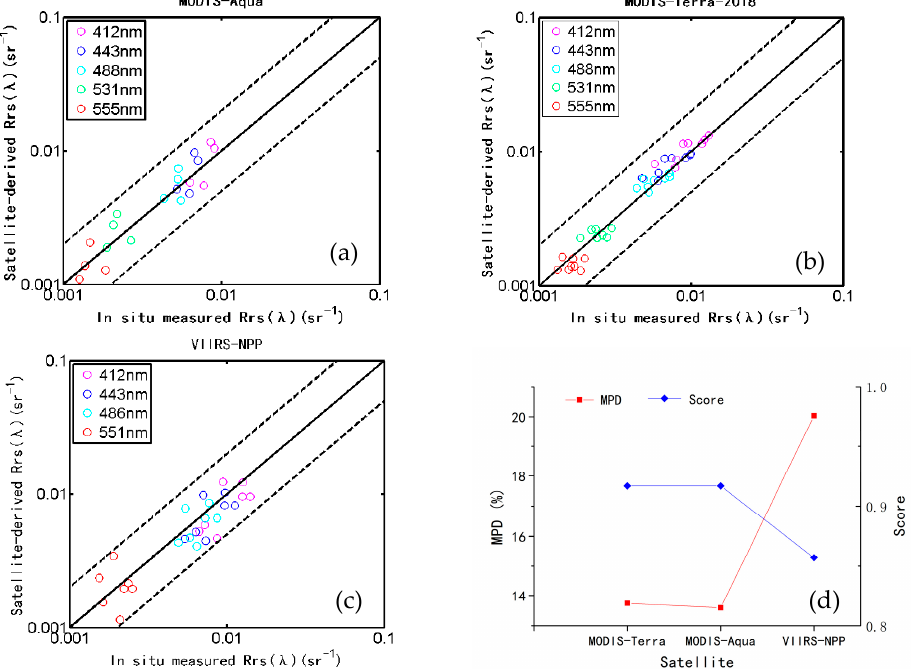
Figure 14. Scatter plots of the satellite–derived R rs ( λ ) versus in situ measurements ( a – c ). Solid line is 1:1 line. Dashed lines are 1:2 and 2:1 lines. The average scores and median absolute percent difference (MPD) of MODIS–Aqua, MODIS–Terra (R2018), and VIIRS–NPP level 2 R rs ( λ ) products concurrent with in situ measurements ( d ).